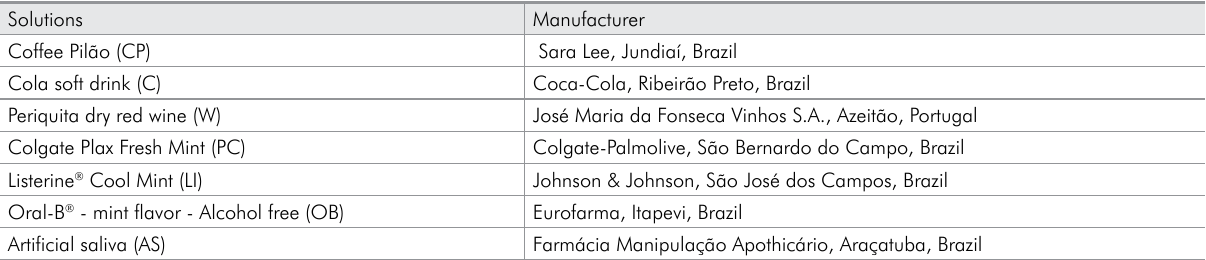
Table 2 - Solutions used in this study.